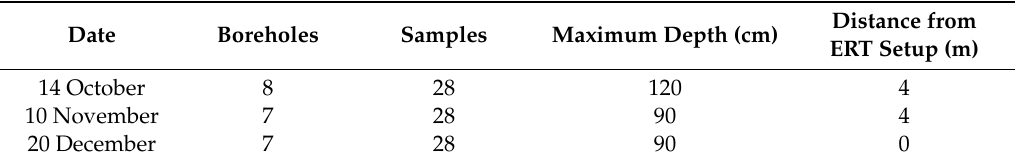
Figure 4. Daily rainfall measured at the experiment site and resistivity ERT measurement taken, the black triangles at the top of the image represent acquisition of ERT profiles. Gravimetric soil moisture was determined three times on 14 October, 10 November, and 20 December as indicated by the green triangles. Table 1. A summary of the soil samples gathered (see also Figure 1).